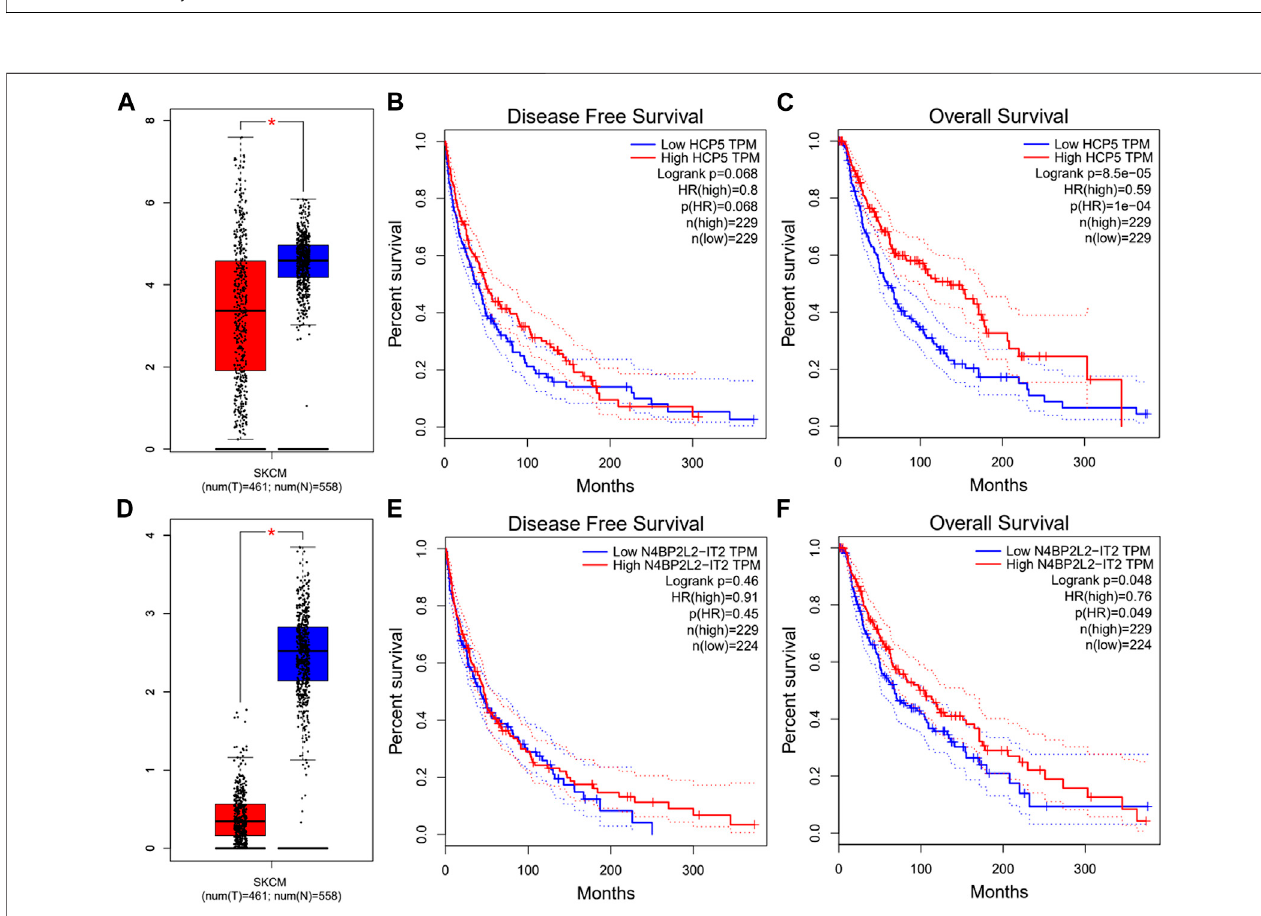
FIGURE5| ExpressionanalysisandsurvivalanalysisoflncRNAupstream ofhsa-miR-3127-5p inSKCM. (A,D) TheexpressionofHCP5 (A) andN4BP2L2-IT2 (D) in TCGA SKCM compared with “ TCGA and GTEx normal ” data. (B,C,E,F) The RFS analysis for HCP5 (B) and N4BP2L2-IT2 (E) in HCC. The OS for HCP5 (C) and N4BP2L2-IT2 (F) in SKCM. * p -value < 0.05.